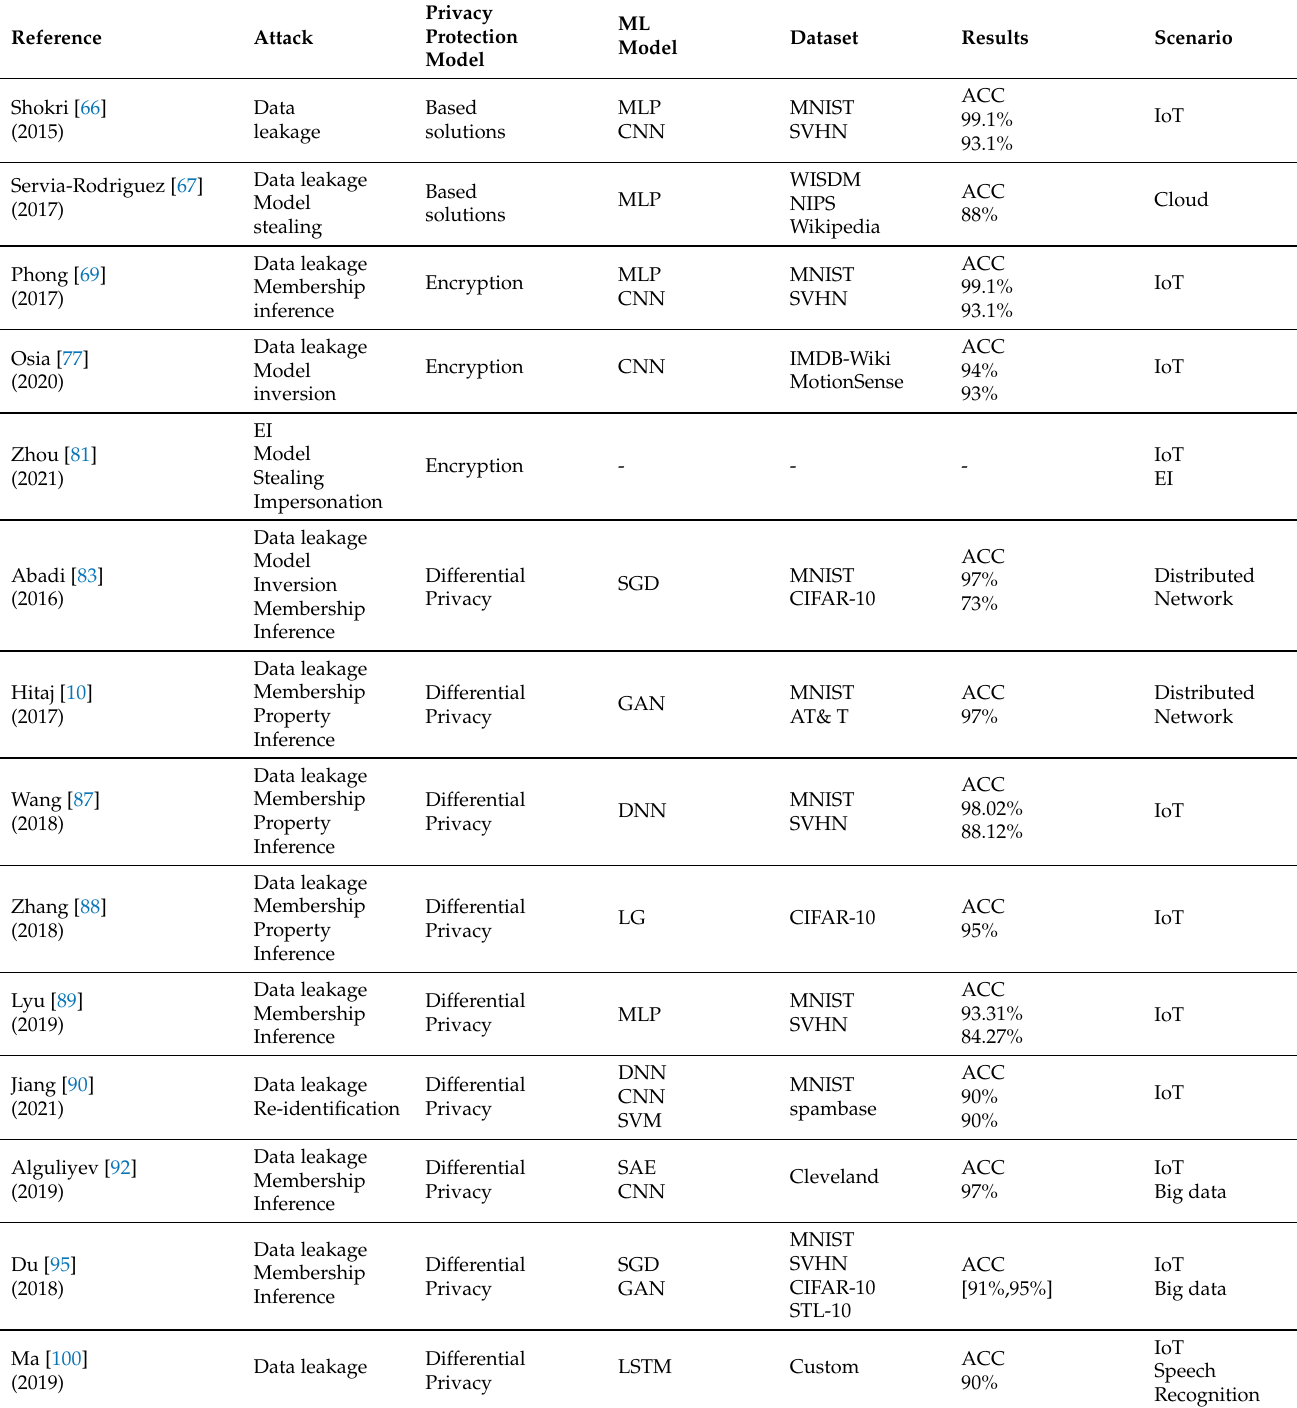
Table 3. ML-based privacy works in IoT environments—Distributed